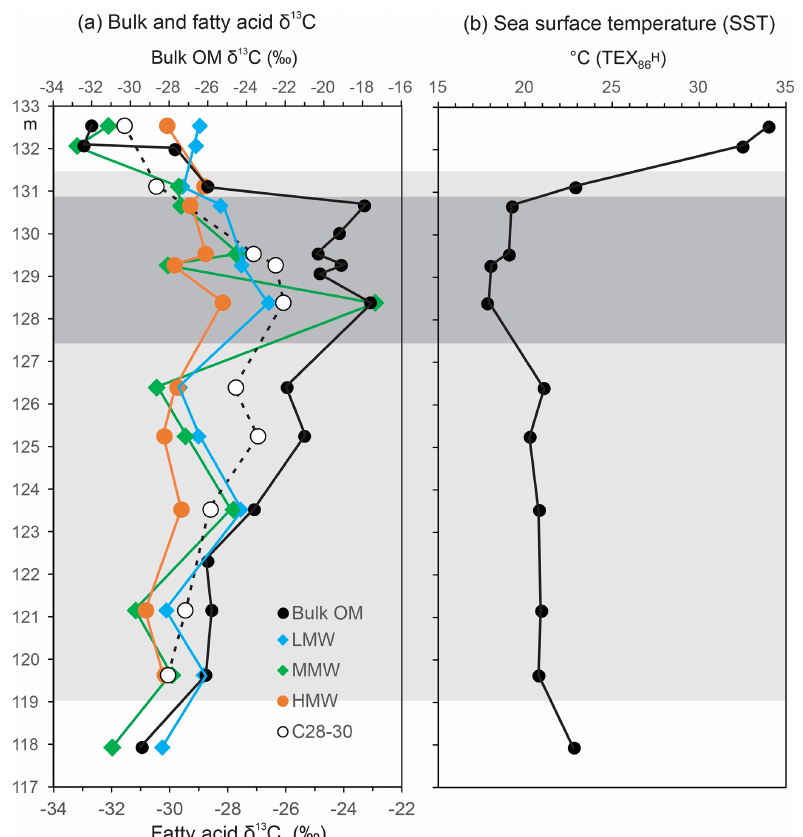
Figure 10. Stratigraphic and facies-related variation in (a) bulk organic and compound-specific δ 13 C values and (b) sea surface temperature in the mid-Waipara section. Average values are plotted for even-numbered LMW (C 16 , C 18 ), MMW (C 20 –C 26 ) and HMW (C 28 –C 32 ) fatty acids, in addition to the mean for C 28 –C 30 fatty acids. Horizontal bands represent OM-poor (pale grey) and OM-rich (medium grey) Waipawa